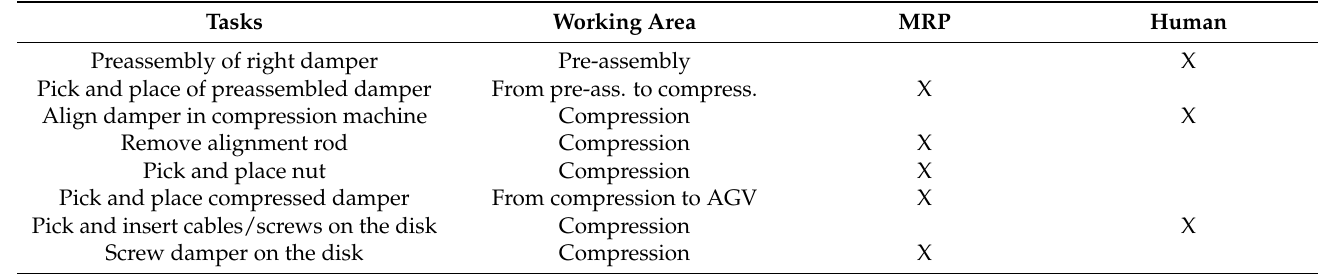
Table 1. High-level description of the use case.